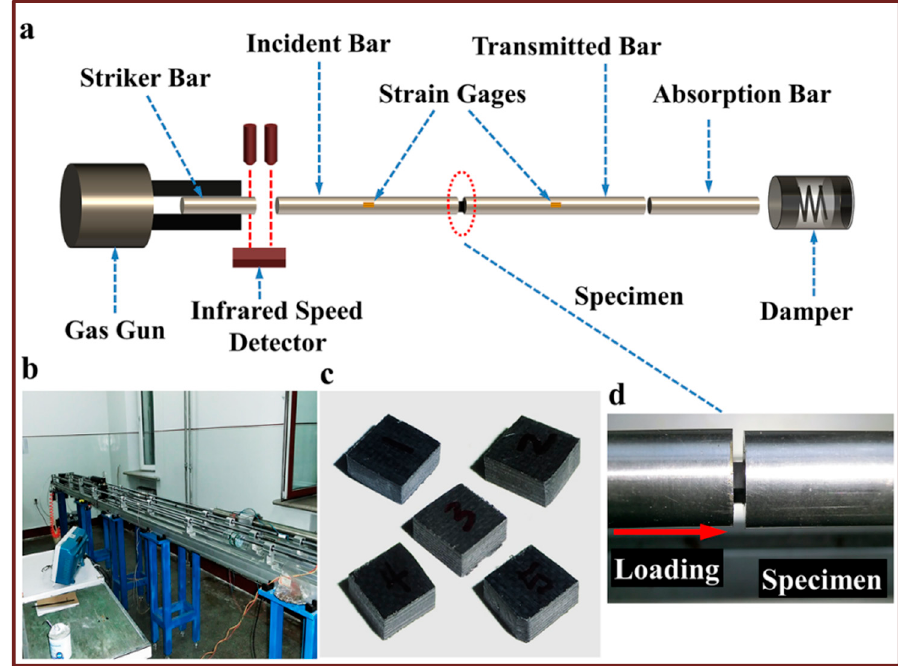
Figure 2. Schematic of a compression split Hopkinson bar apparatus and specimen assembly scheme. ( a ) A schematic diagram of the SHPB apparatus. ( b ) The SHPB setup employed in our tests. ( c ) Geometry of the specimen in compression. ( d ) Position and loading direction of the specimen.